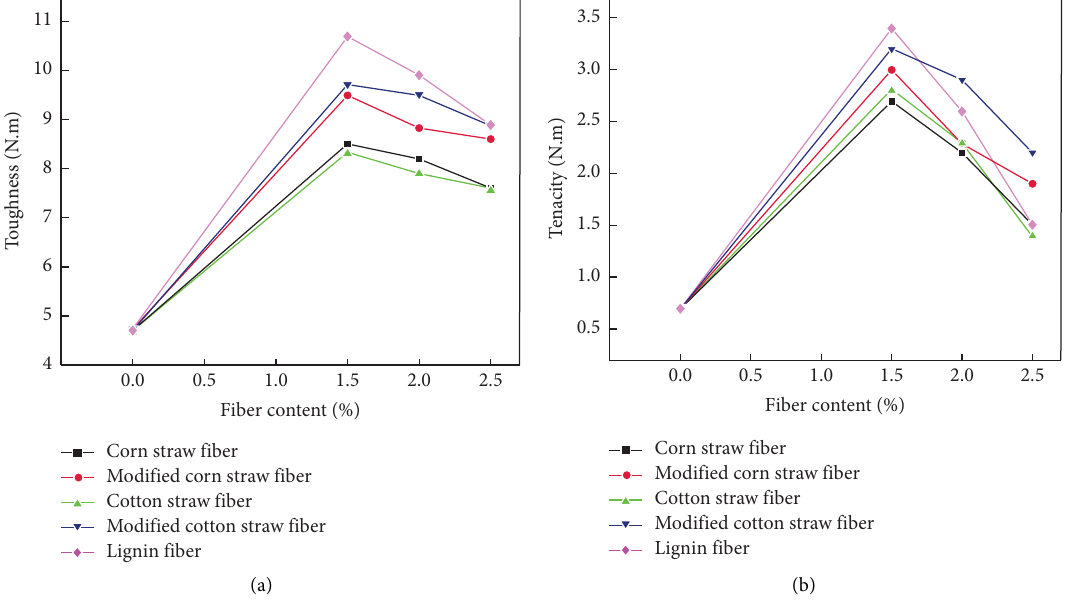
Figure 10: Efects of fber content and type on (a) toughness and (b) tenacity of asphalt